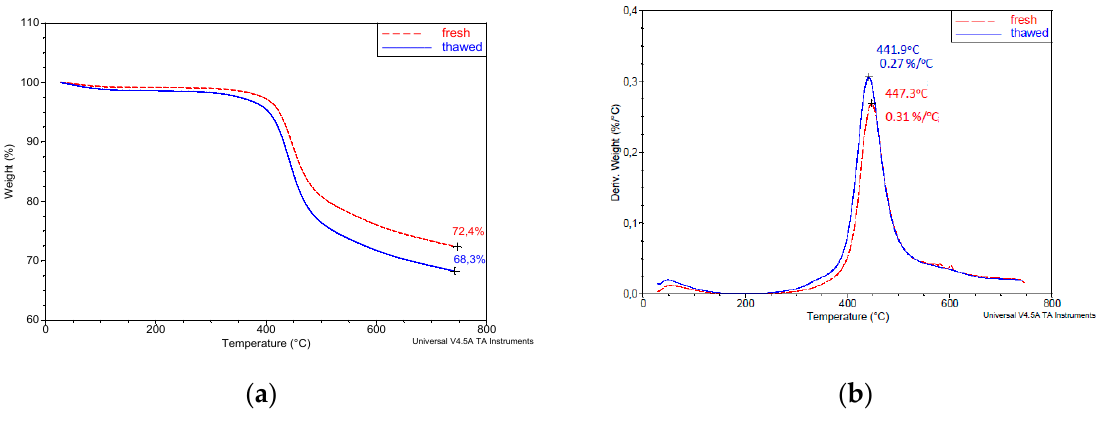
Figure 1. The curves of mass loss ( a ) and mass loss rate ( b ) of fresh and thawed coals depending on the temperature.